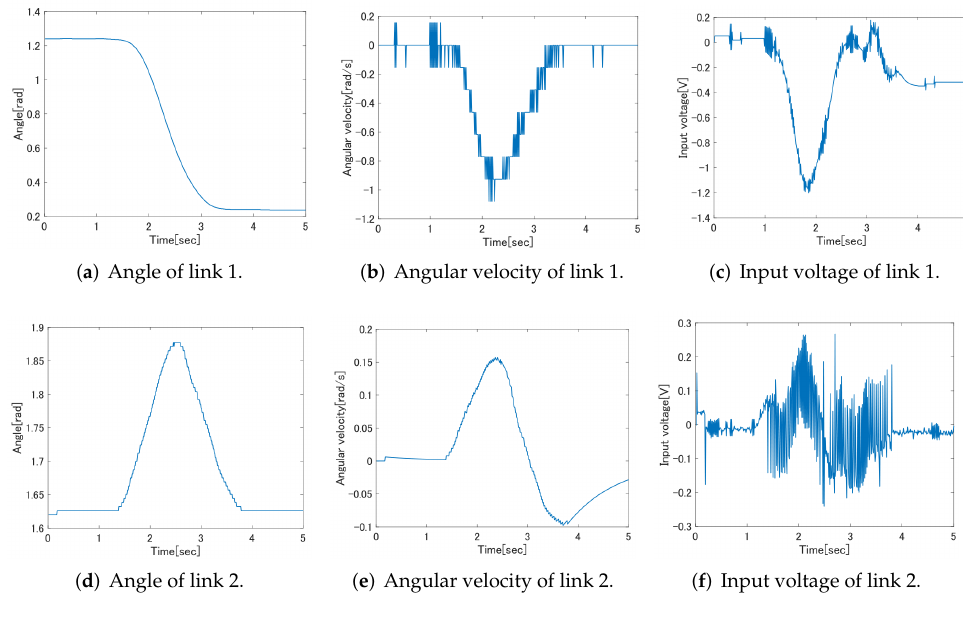
Figure 8. Training data of Link 1 and Link